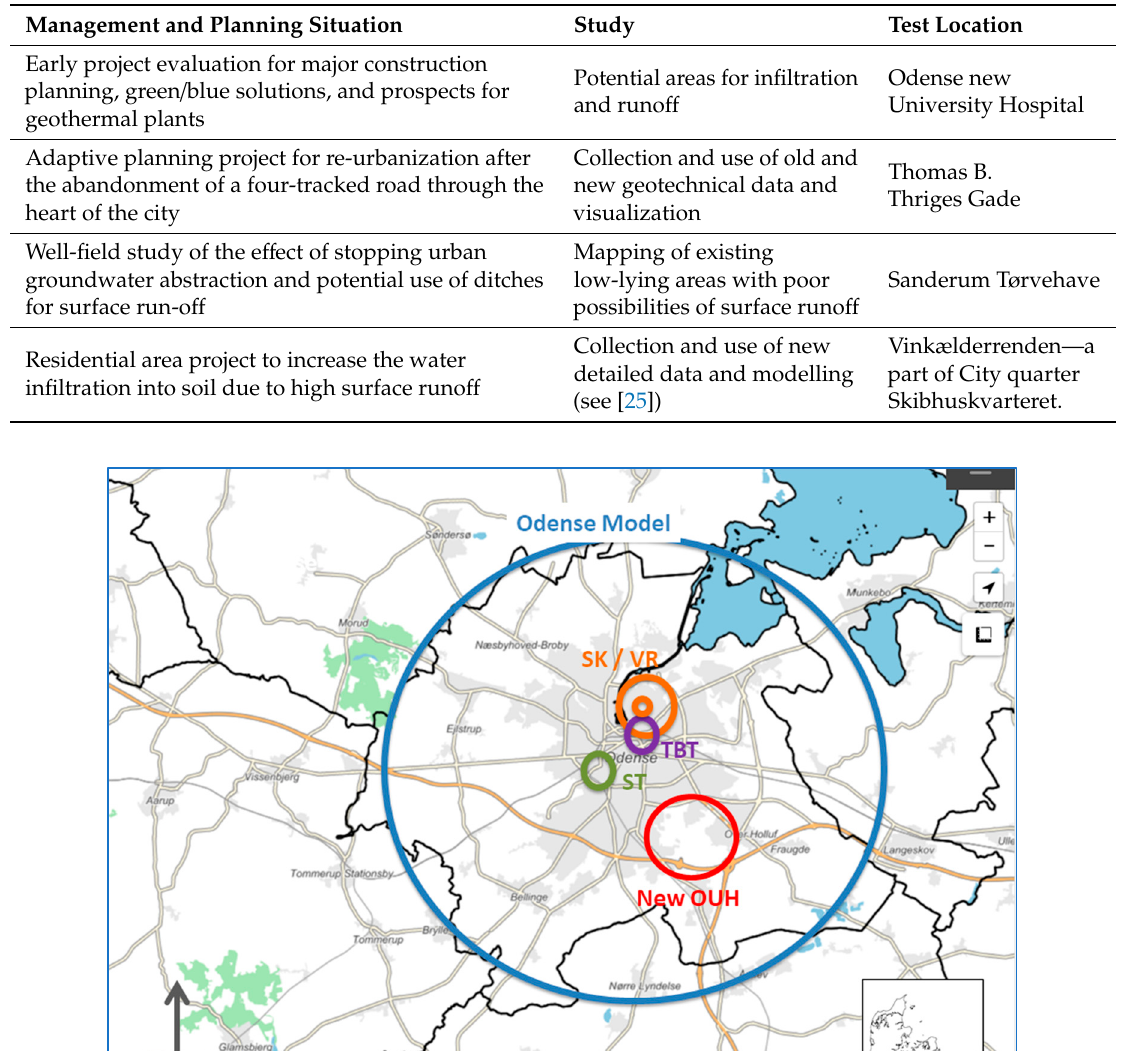
Table 5. Adaptive ‘real’ planning and governance projects chosen for design of the ‘new’ urban hydrogeological model in Odense.